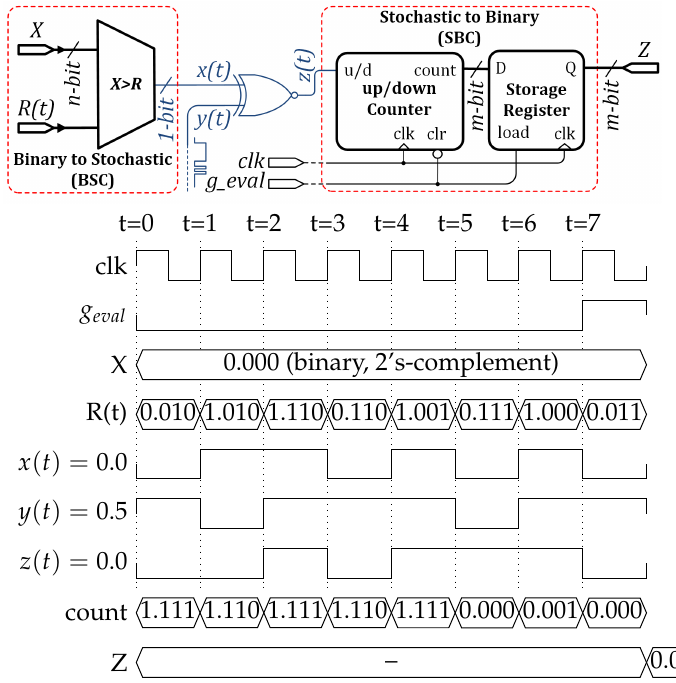
Figure 4. Example of a SC bipolar multiplier. Two switching inputs x and y represent signals 0 and 0.5, respectively. Afterward, they are multiplied through the XNOR gate, leading to signal z = 0.0. Signal y ( t ) is generated with an independent RNG (not shown in the picture). Stochastic signals are colored in